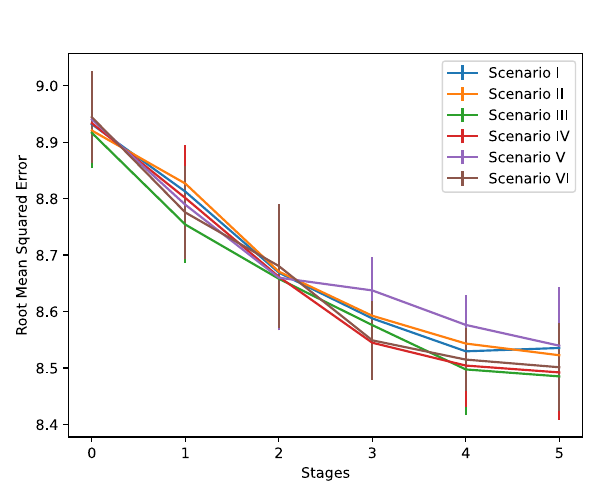
Figure 7. Performance of the autoencoders along the five learning stages for the six